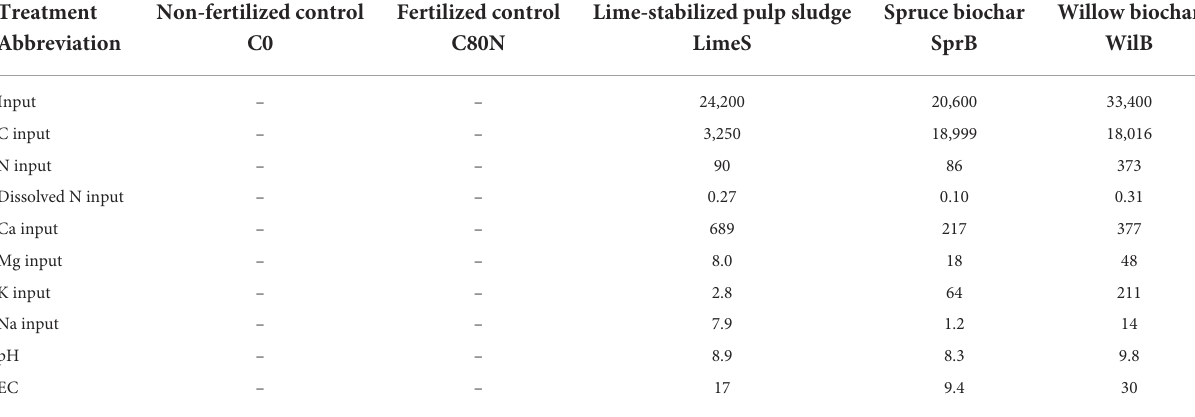
TABLE 1 Experimental treatments including their application rates in